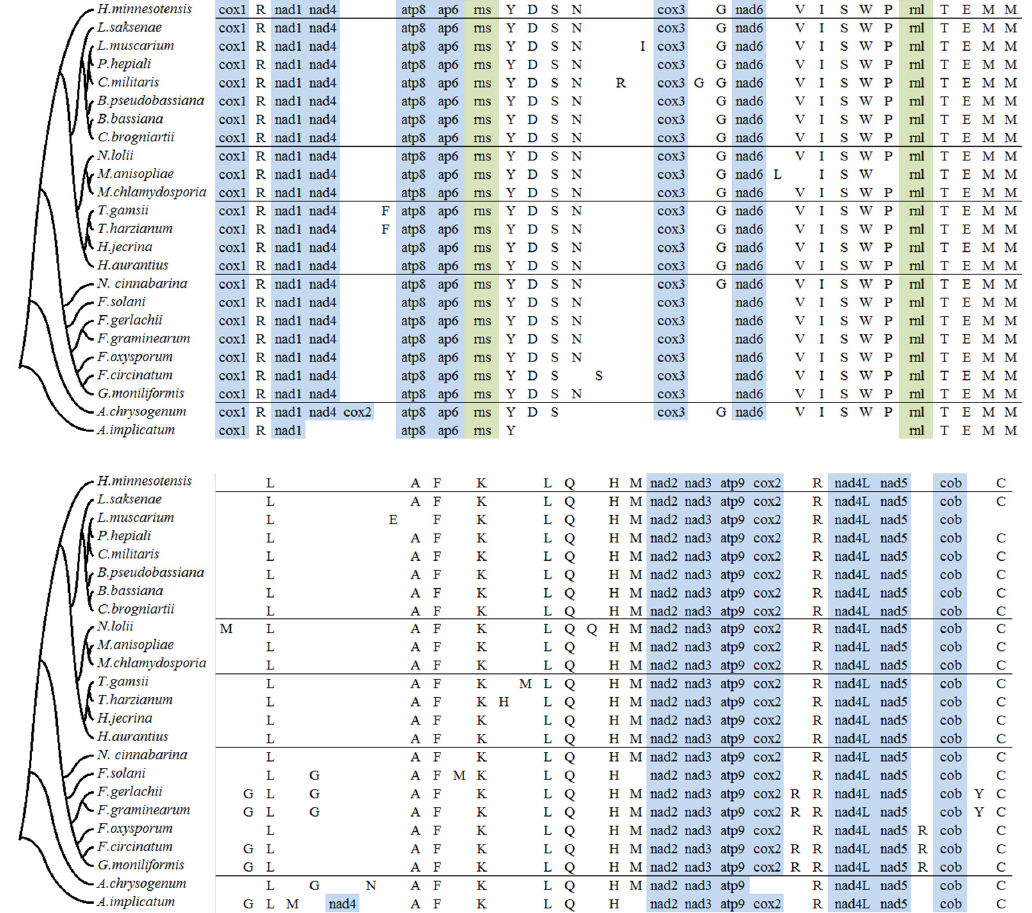
Figure 3. tRNA gene distribution and gene order comparison of 24 mitochondrial genomes in Hypocreales . Conserved protein coding genes (blue), rRNA (olive green) and tRNA genes were used. tRNA s with unknown function were not included . The fungi compared here were corresponding to 24 species used for phylogenetic tree construction. tRNA genes were indicated by their abbreviated letters.